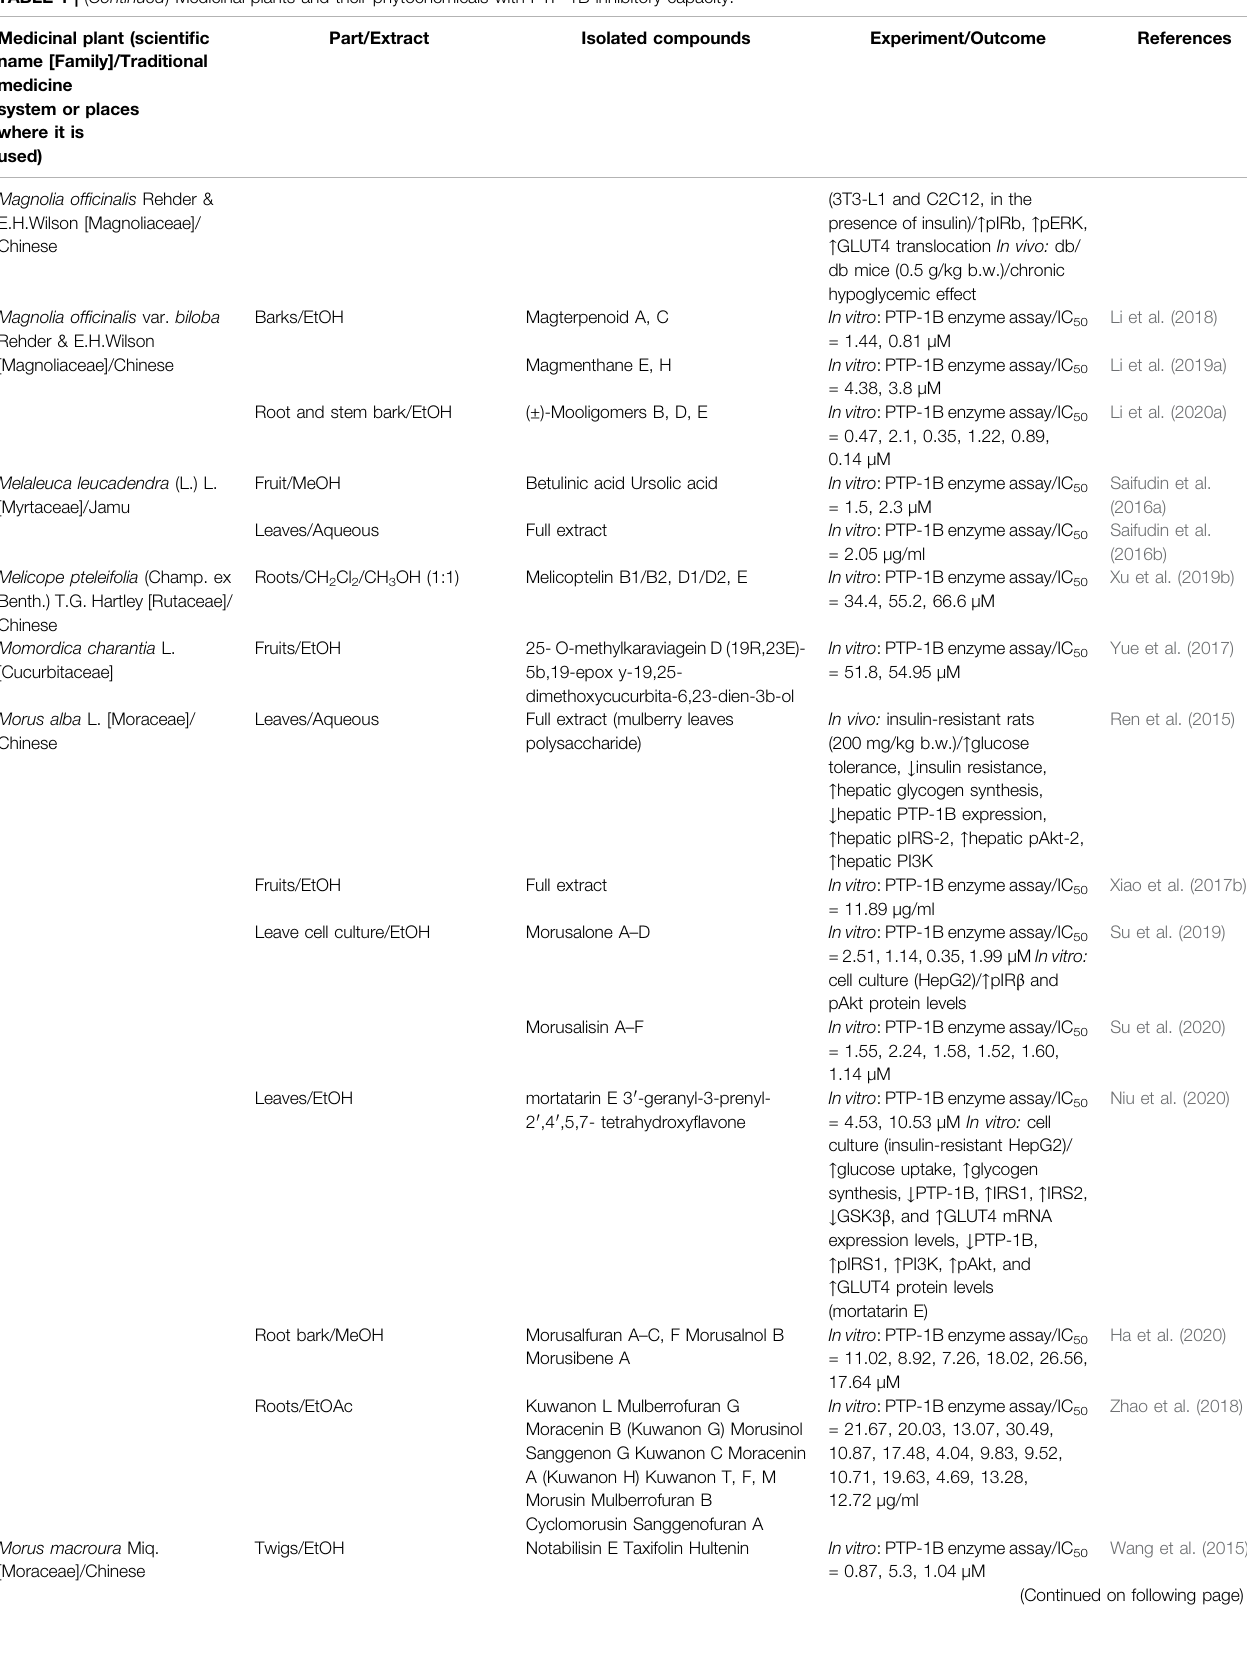
Medicinal plant (scienti fi c name